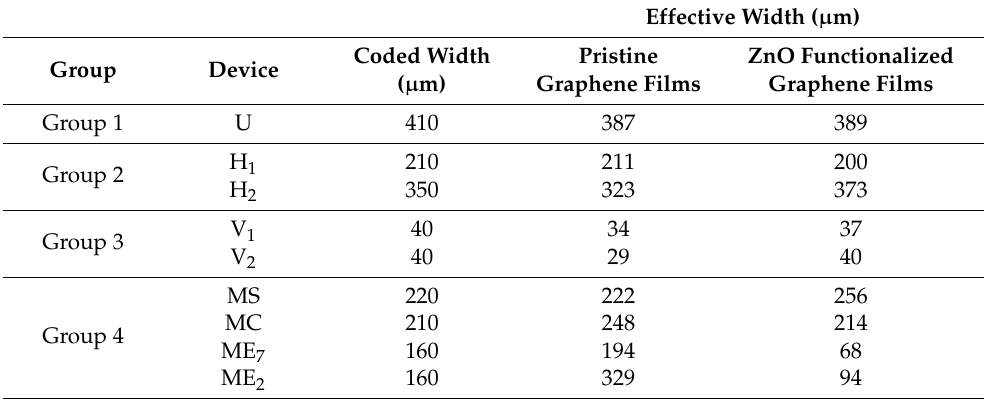
Table 5. Summary of coded width and effective width for pristine and ZnO functionalized graphene device